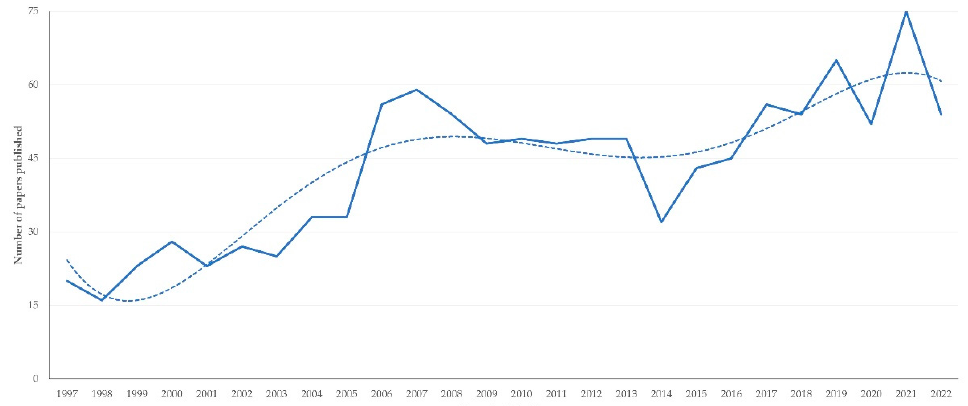
Figure 1. Number of papers on sheep and goats published annually during 1997–2022 from Greece (dashed line indicates trendline).